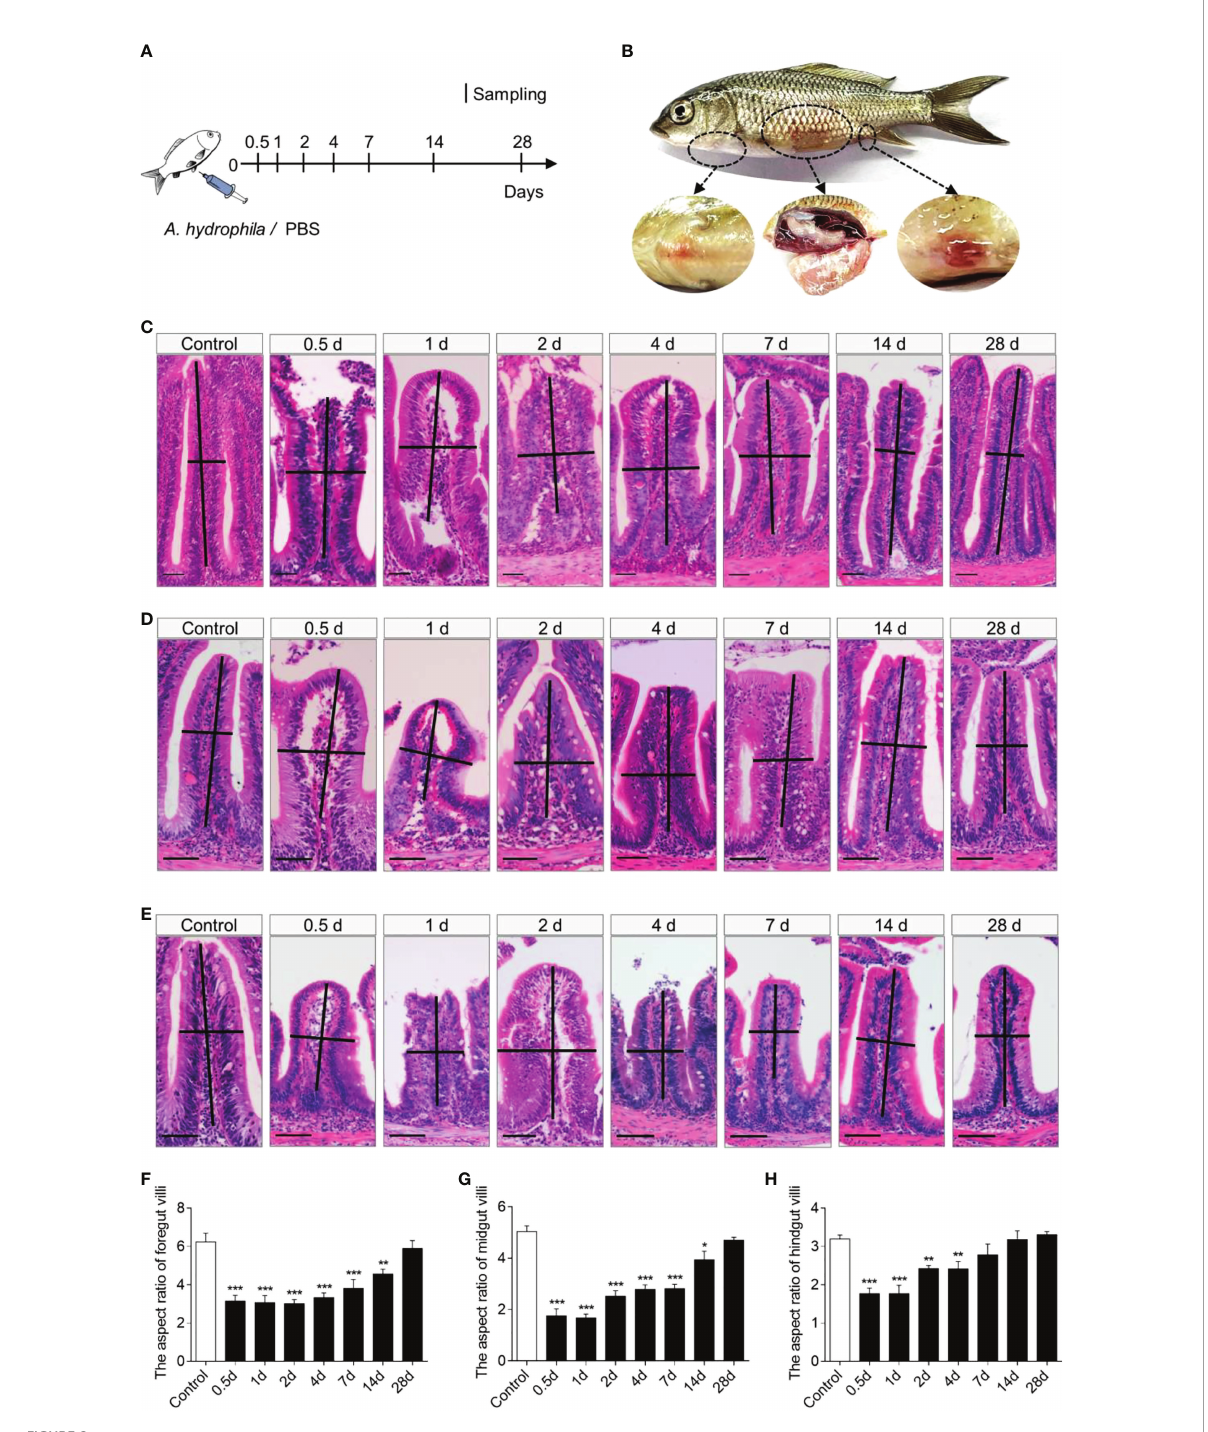
FIGURE 2 Scheme of the infection strategy with A . hydrophila via intraperitoneal injection. (A) Fish were injected with A. hydrophila and sacri fi ced at 0.5, 1, 2, 4, 7, 14, and 28 DPI for sample collection, while fi sh were injected with PBS as control. (B) The clinical observation following challenge with A. hydrophila . (C – E) Histological examination by H&E staining of foregut (C) , midgut (D) , and hindgut (E) from control and infected fi sh ( n = 6). Scale bars, 50 m m. (F – H) The length-width ratio of foregut (F) , midgut (G) , and hindgut (H) intestinal folds in these groups of fi sh from (C – E) ( n = 6). * P < 0.05, ** P < 0.01, and *** P < 0.001 (one-way ANOVA with Bonferroni correction). Data are representative of at least three independent experiments (mean ±